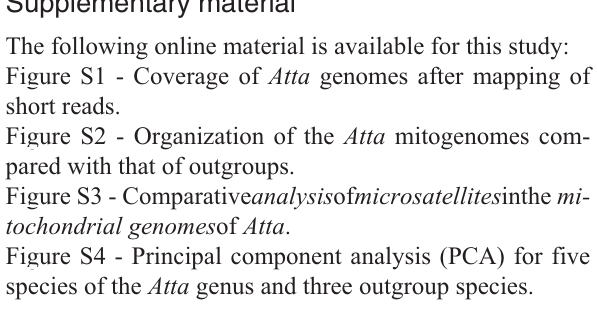
short reads. Figure S2 - Organization of the Atta mitogenomes com- pared with that of outgroups. Figure S3 - Comparative analysis of microsatellites inthe mi- tochondrial genomes of Atta . Figure S4 - Principal component analysis (PCA) for five species of the Atta genus and three outgroup